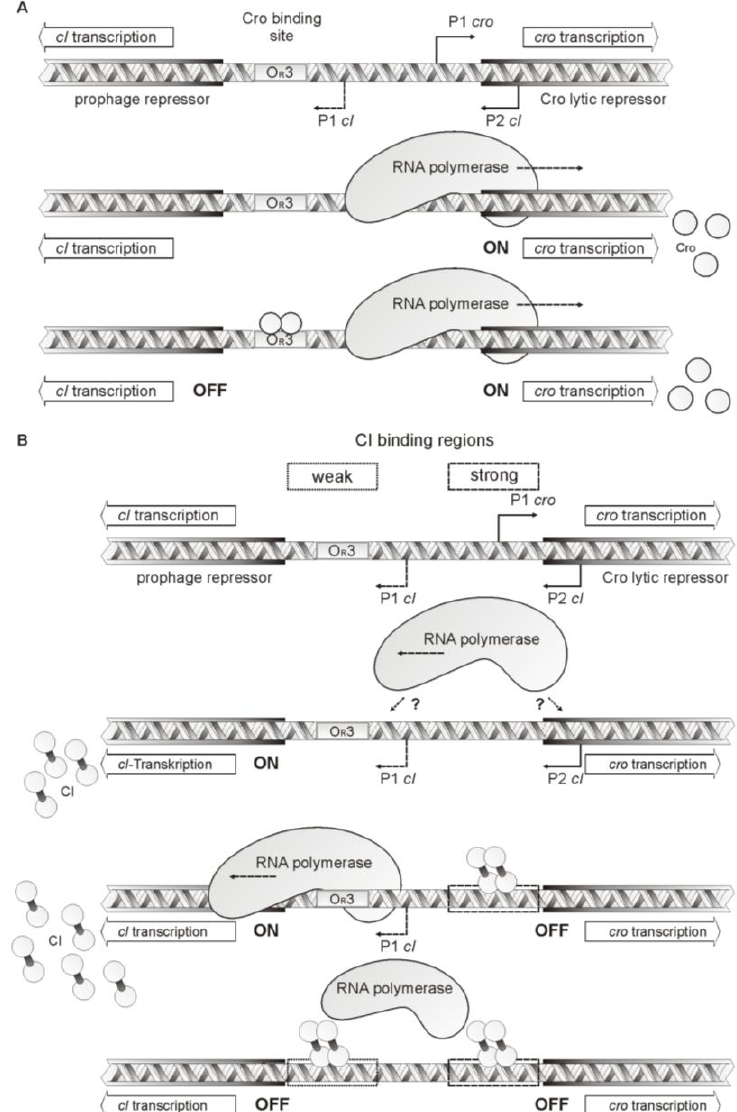
Figure 8. Model for PY54 repressor activity. ( A ) Influence of PY54 lytic repressor binding on cI and cro transcription. The upper part shows the location of cI and cro , the positions of the identified promoters and the Cro binding site O R 3. In the middle, binding of the RNA polymerase to the strong cro promoter is illustrated. This leads to cro transcription and the synthesis of lytic repressor molecules. Whether there is any transcription of cI at this stage, is unknown. Upon Cro synthesis, the protein binds to O R 3 resulting in a blocking of cI transcription whereas transcription of cro can still take place; ( B ) Influence of PY54 prophage repressor binding on cI and cro transcription. The upper part shows the location of cI and cro , the positions of the identified promoters, the Cro binding site and CI binding regions. In the next diagram, possible binding of the RNA polymerase to the cI promoters is illustrated. It leads to cI transcription and the synthesis of prophage repressor molecules. Whether there is any transcription of cro at this stage, is unknown. Upon CI synthesis, the protein binds next to the start of the cro gene resulting in a blocking of cro transcription, whereas transcription of cI can still take place. High concentrations of CI molecules may lead to additional binding next to cI resulting in the repression of cI transcription.